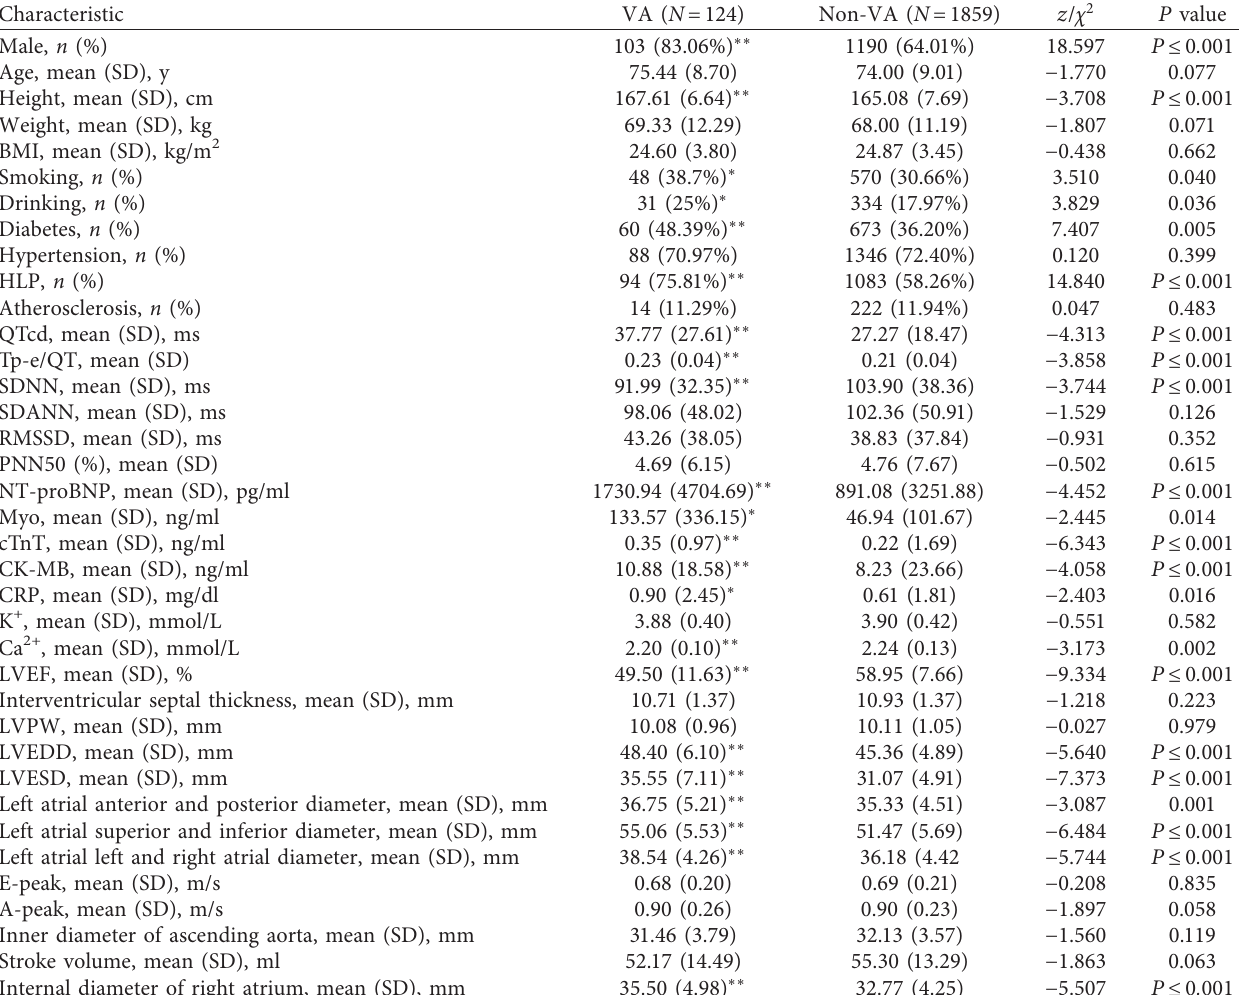
Table 1: Comparison of demographic and clinical characteristics between VA and non-VA groups.